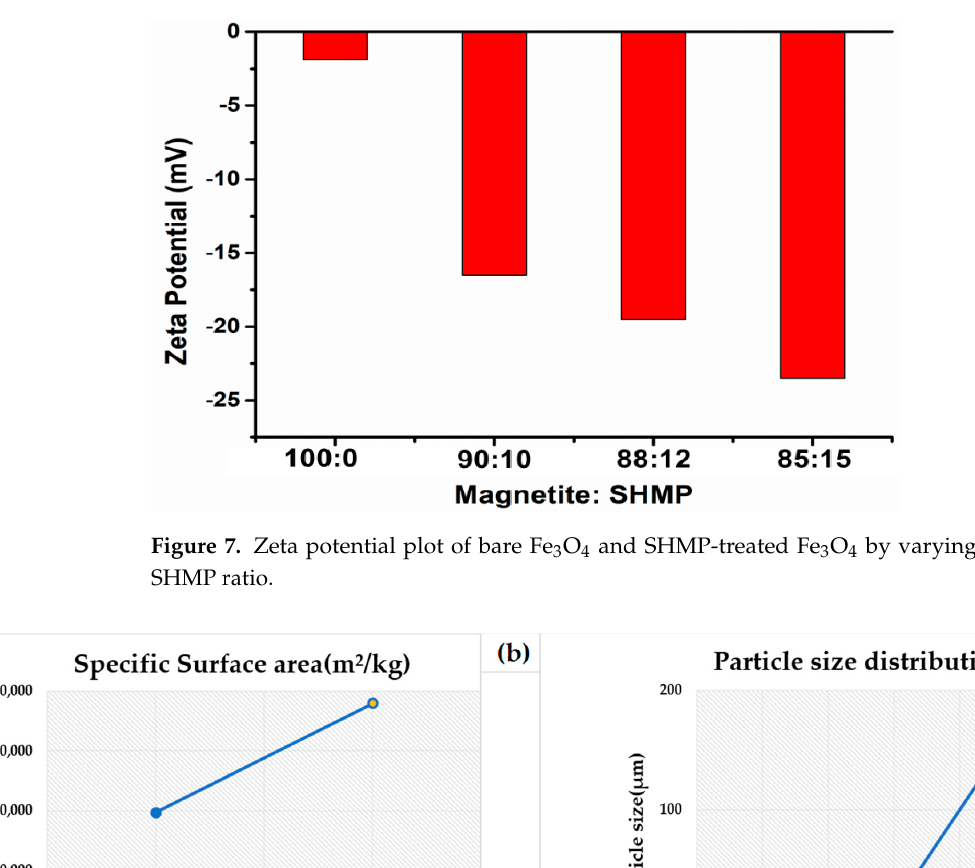
Figure 8. ( a ) Specific surface area, ( b ) Particle size distribution plot of bare Fe 3 O 4 and SHMP-treated Fe 3 O 4 . 3.5. X-ray Photoelectron Spectroscopy Studies of Bare IG-Fe 3 O 4 and SHMP-Treated Fe 3 O 4